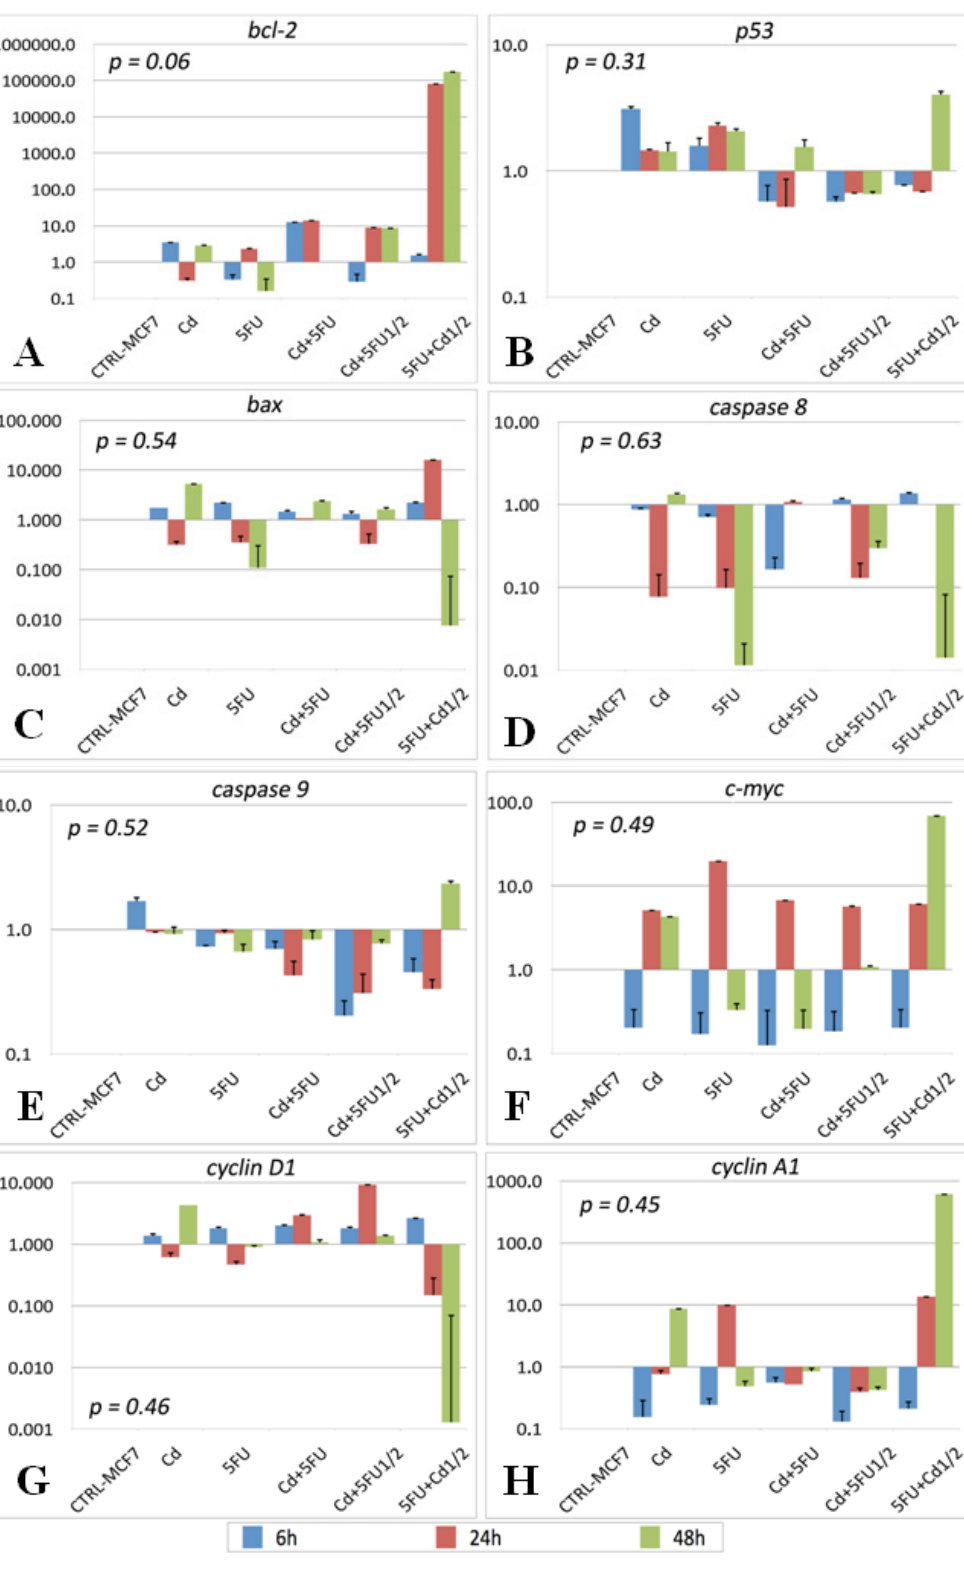
Figure 2. Determination by qRT-PCR of gene expression after treatment with Cd and/or 5-FU for 6, 24, or 48 h. The fold-increase in expression was quantified after normalizing expression levels for those in control MCF-7 cells. Gene expression of bcl-2 ( A ); p53 ( B ); bax ( C ); caspase 8 ( D ); caspase 9 ( E ); c-myc ( F ); cyclin D1 ( G ); cyclin A1 ( H